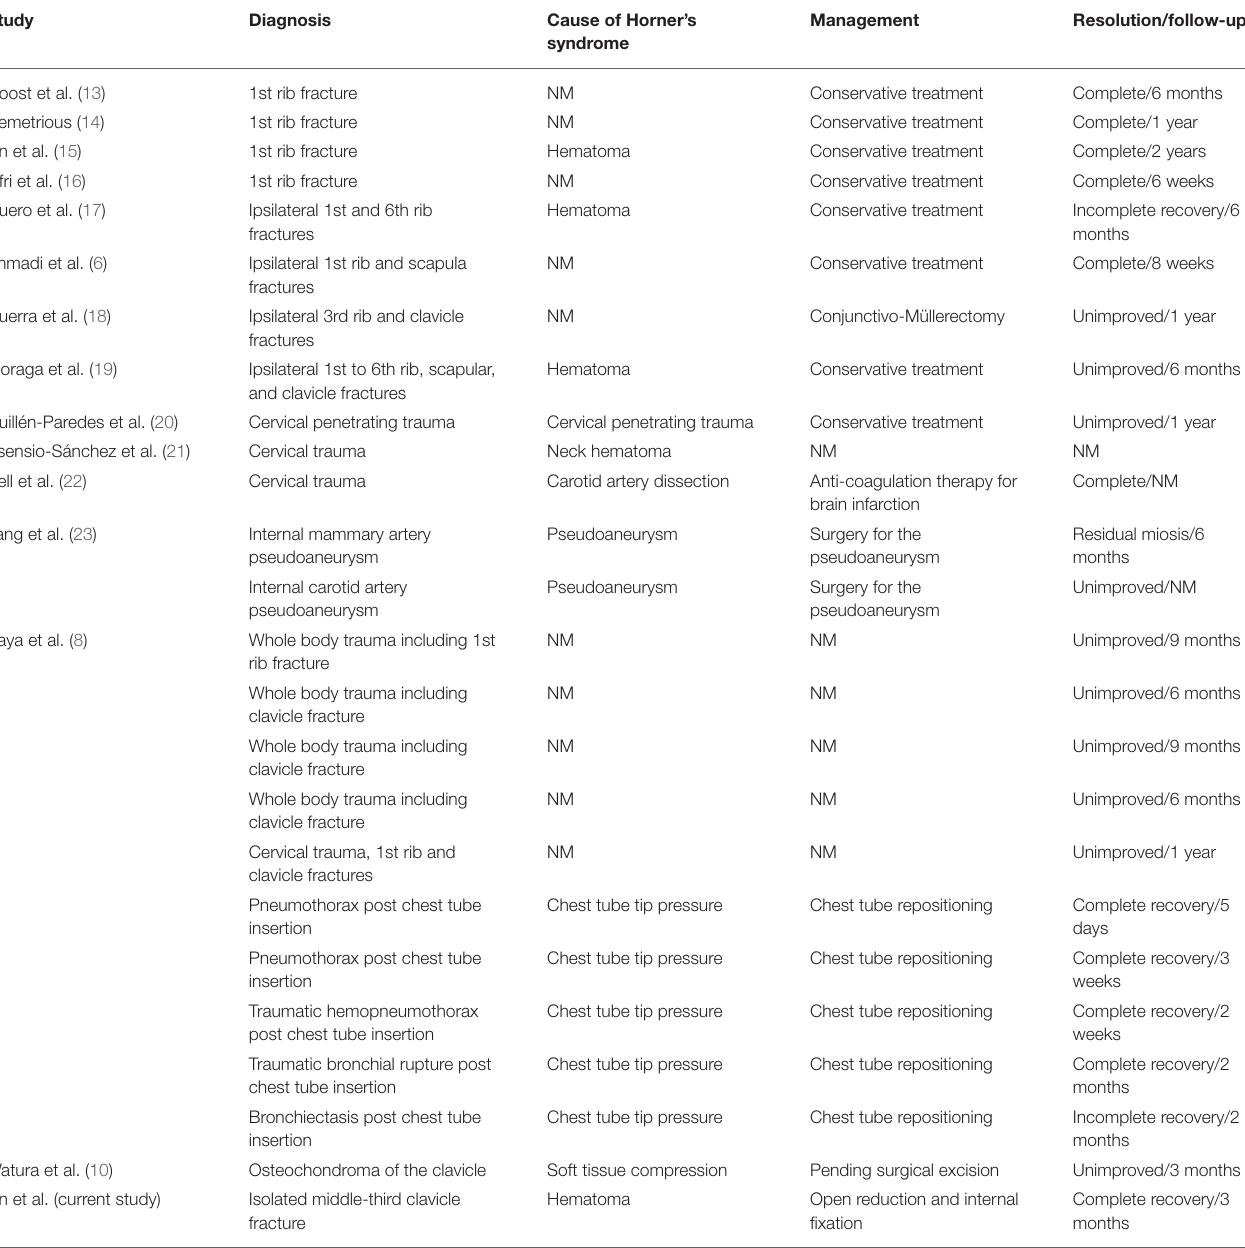
TABLE 1 | Summary of the literature review of trauma-related Horner’s